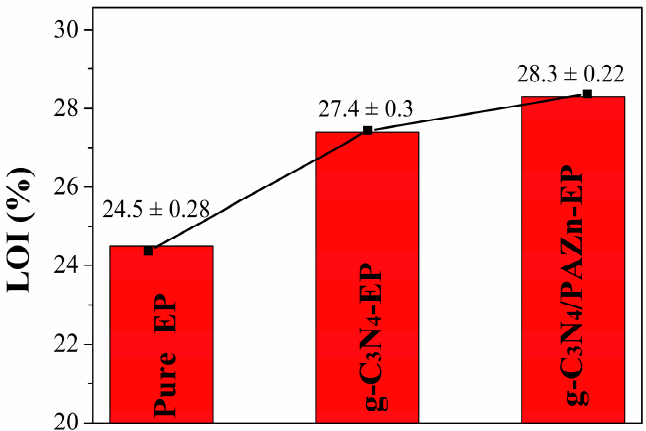
Figure 4. Limiting oxygen index (LOI) values of EP composites.